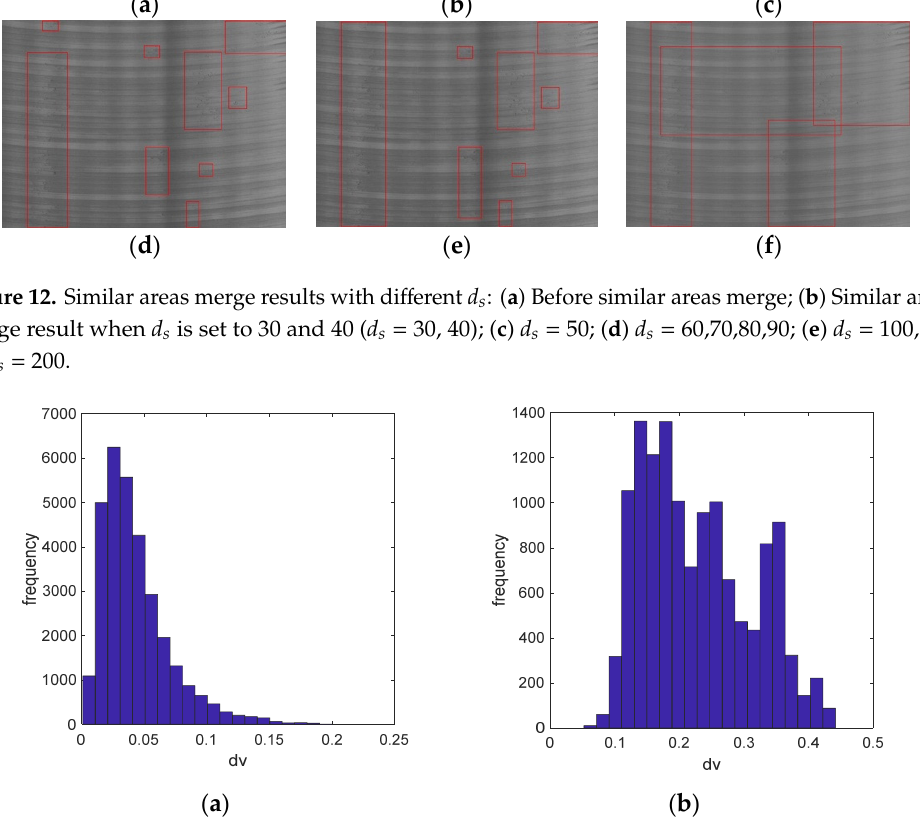
Figure 13. The Euclidian distance ( d v ) histogram of similar areas and dissimilar areas: ( a ) Similar areas distance histogram; ( b ) Dissimilar areas distance histogram.